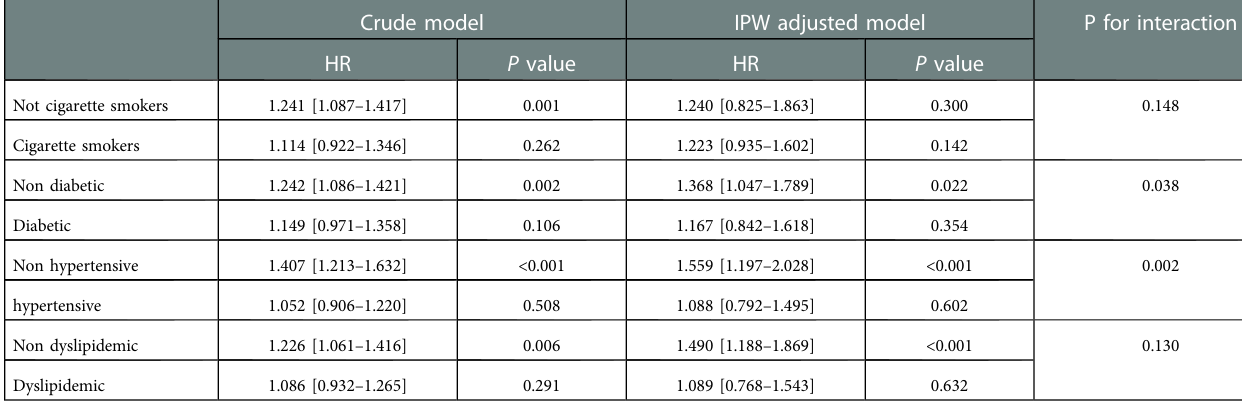
TABLE 3 Mortality hazard ratios for opium consumption based on each CAD risk